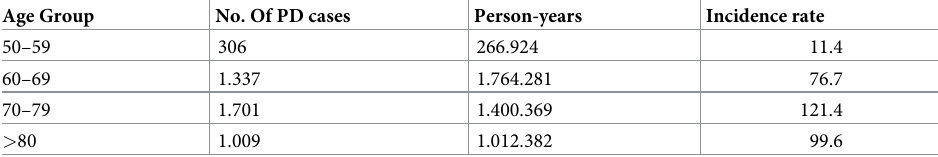
Table 3. Age-adjusted incidence rates for Norwegian Prescription